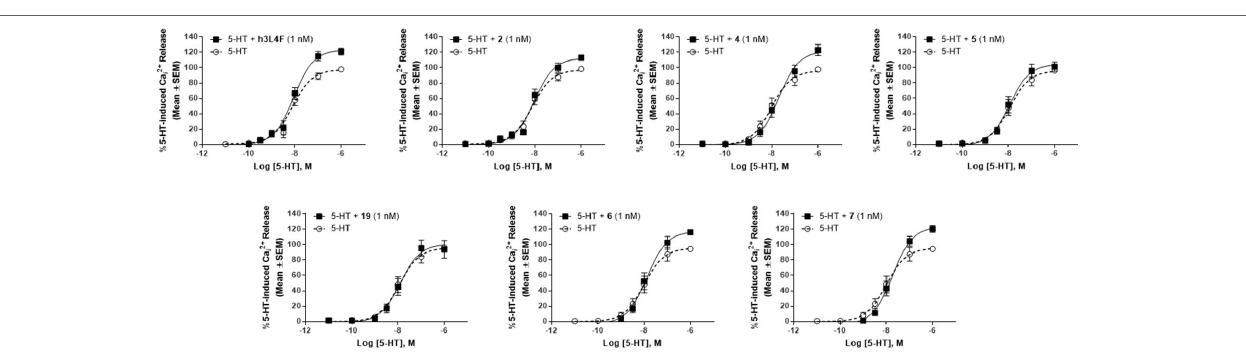
FIGURE 6 | Effects of peptide 2 derivatives on Ca i 2+ release in live h5-HT 2C R-CHO cells in the absence (open circles) and presence of 1 nM compound (closed circles) against the concentration–response curve for 5-HT. The maximum 5-HT-induced Ca i 2+ release in the absence of the peptide derivatives was set as 100%. Figures represent an average of 4–5 biological replicates. E MAX values are reported in Table 1 .